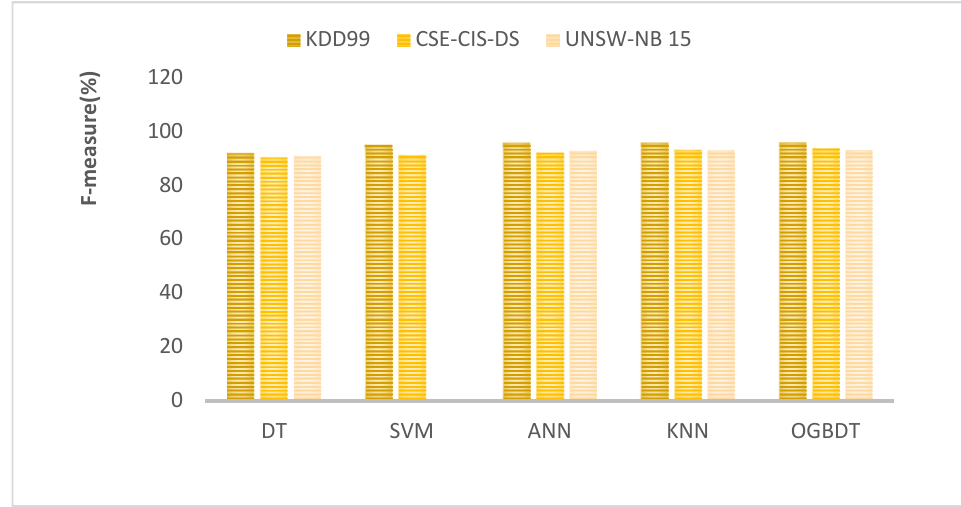
Figure 6. F-measure rate comparison.